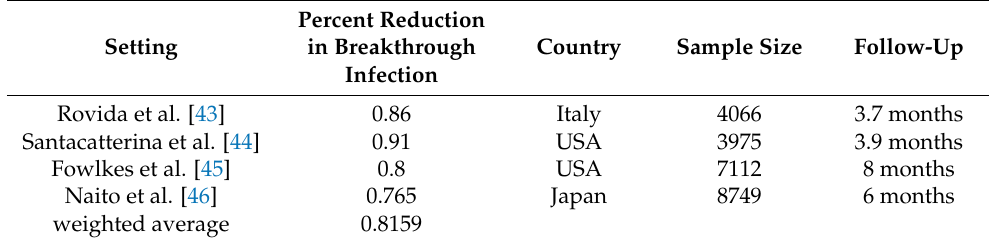
Table 2. Comparison of studies assessing the degree of reduction in risk of breakthrough infection compared to primary infection (namely, the protective effects of vaccine-induced